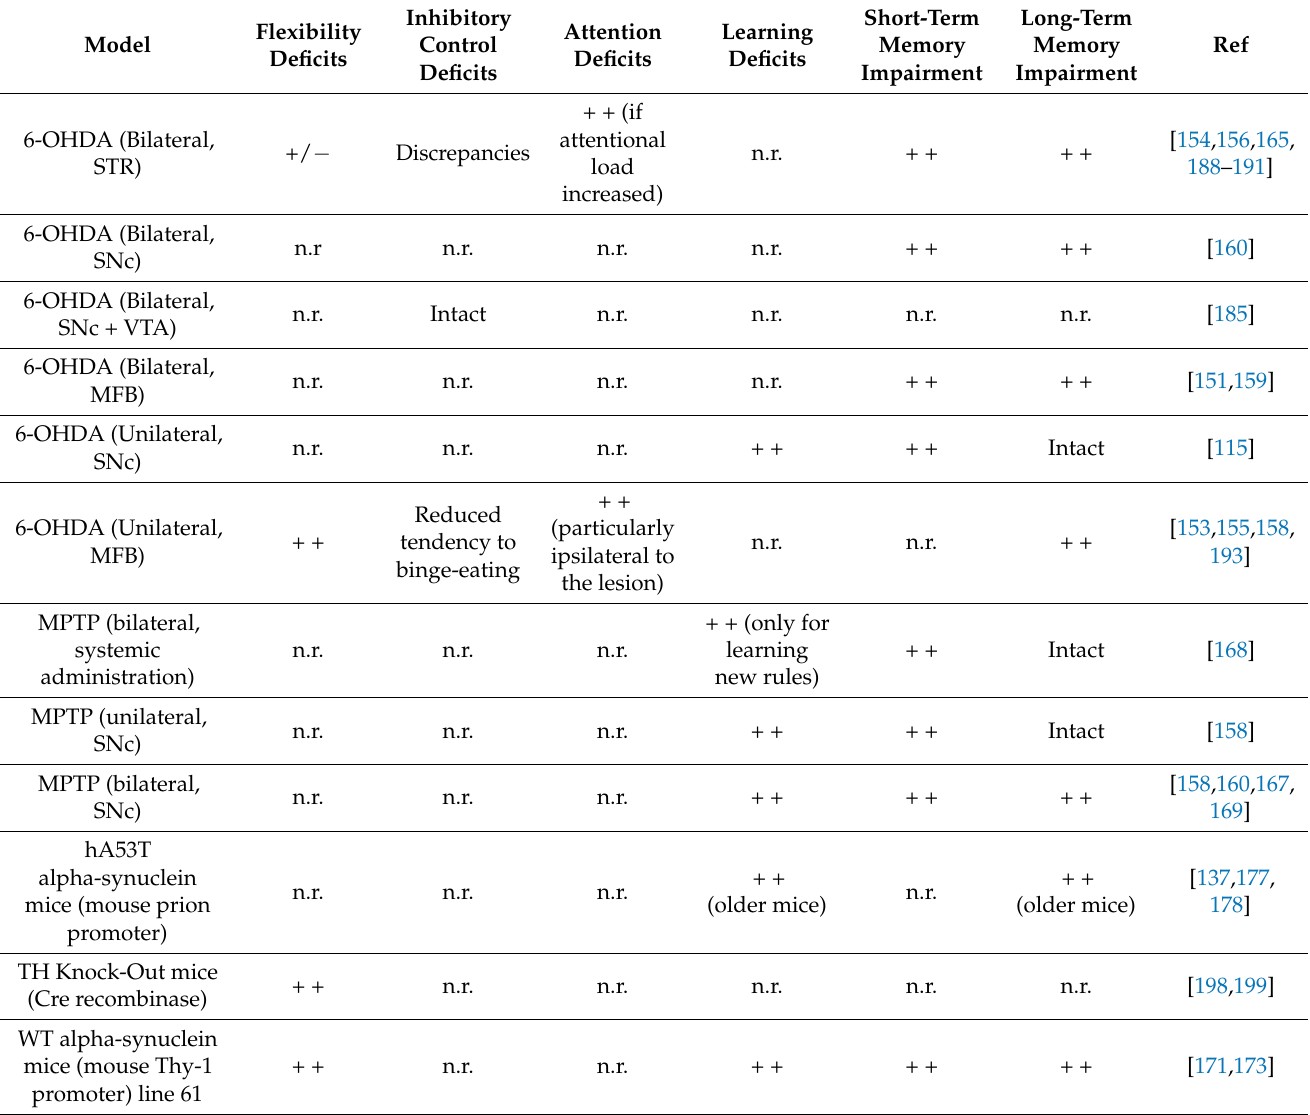
Table 2. Overview of cognitive deficits in rodent models of PD. +/ − = presence or absence depending on studies, + + = presence, n.r. = non